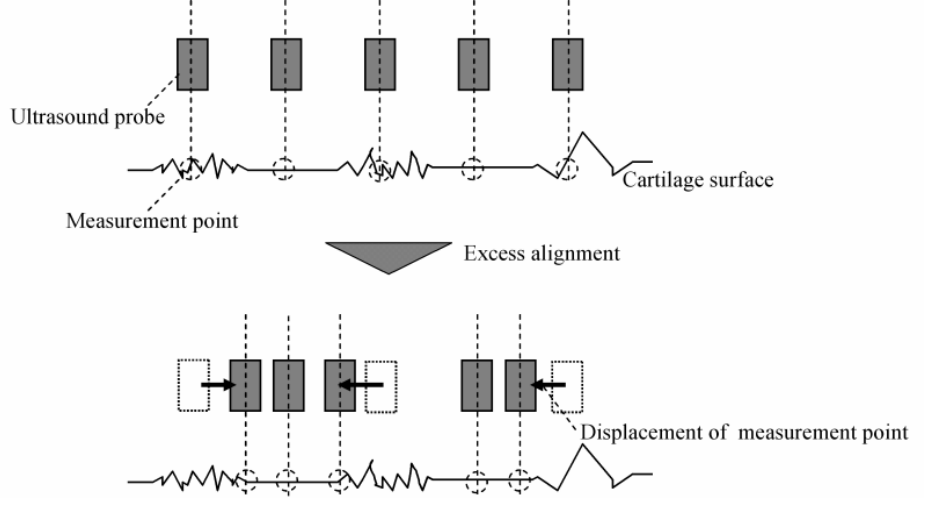
Figure 1: The operator must manipulate the ultrasound probe such that the echo amplitude is maximized to make sure that the probe is perpendicular to the cartilage surface. If the cartilage surface has some lesions, it is possible that this manipulation using echo amplitude as the index of the probe angle can result in the unconscious avoidance of rough